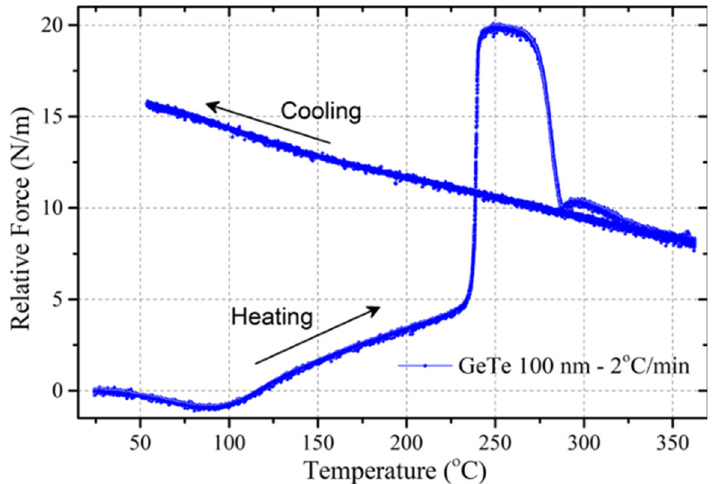
Figure 2. Relative force as a function of temperature for a 100 nm thick GeTe film deposited on Si and capped with 10 nm SiO 2 . Heating rate is 2 °C/min.